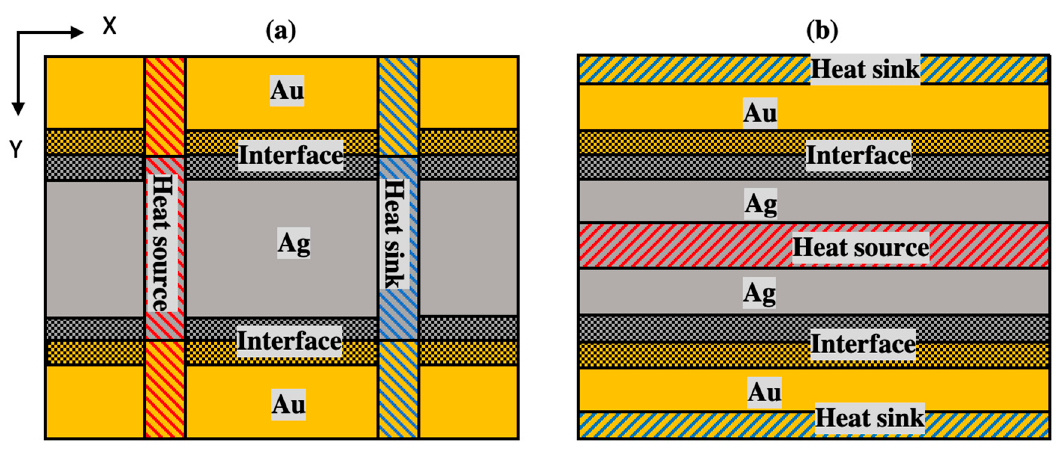
Figure 3. Schematic of systems designed to study the solid-solid interfacial thermal conductivity. The simulation box dimensions are 49.08 × 98.16 × 49.08 Å. System ( a ) is designed for studies of the interfacial thermal conductivity parallel to the interface. This interface is referred to as δ || in the text. System ( b ) is the design for the interfacial thermal conductivity perpendicular to the interface. The thickness of this interface is referred to as δ ⊥ .